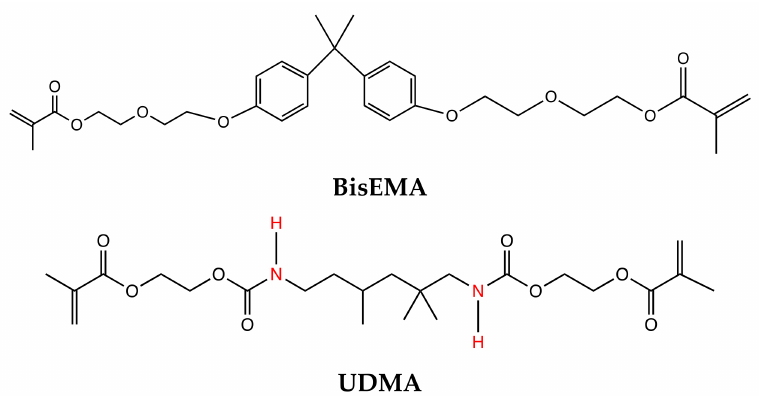
Figure 6. Chemical Structure of resin monomers. Bisphenol A ethoxylate dimethacrylate (BisEMA) and Urethane dimethacrylate